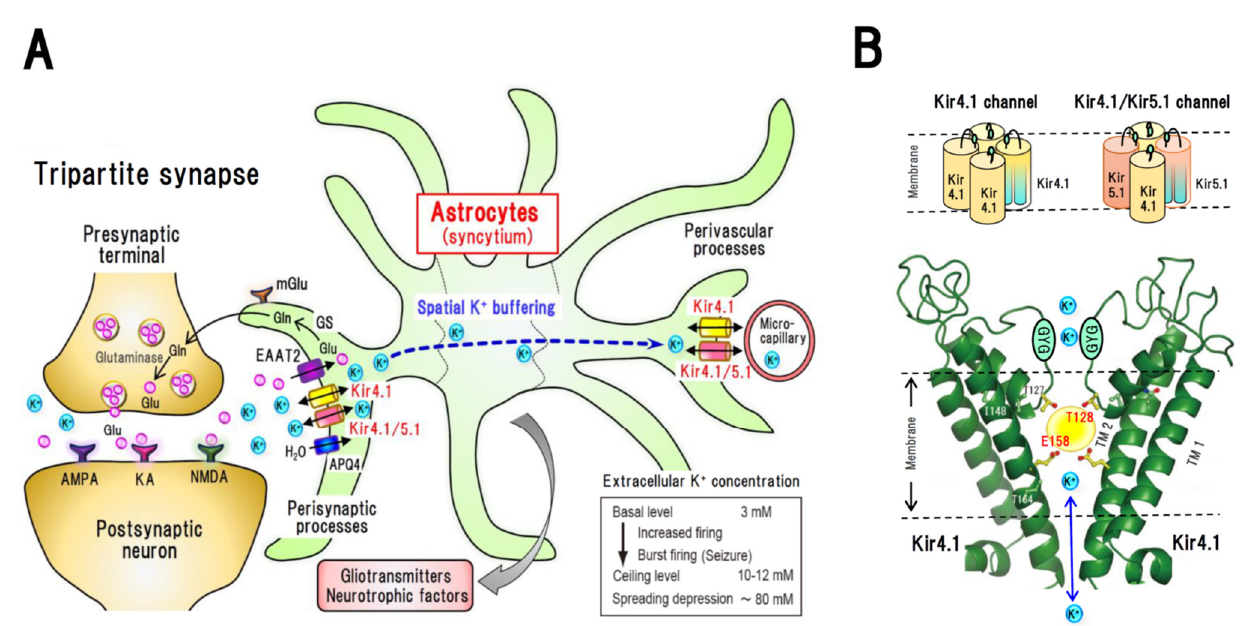
Figure 1. Spatial potassium (K + ) buffering by astrocytes in tripartite synapses and inwardly rectifying Kir4.1 channels. ( A ): Kir4.1 channel-mediated spatial K + buffering function of astrocytes. The Kir channel subunits Kir4.1 and Kir5.1 are specifically expressed in astrocytes and co-localized with excitatory amino acid transporter 2 (EAAT2) and aquaporin 4 (APQ4) in the perisynaptic processes. Astrocytic Kir4.1 channels mediate spatial K + buffering, a clearance system for excessive extracellular K + in synapses, controlling the extracellular K + levels at concentrations of 3–5 mM and maintaining the ceiling level of around 10–12 mM even during seizure discharges. When the function of Kir4.1 channels is disrupted under disease conditions, extracellular K + levels can readily increase to induce abnormal firing of neurons. AMPA: α -amino-3-hydroxy-5-methyl-4-isoxazolepropionic acid (AMPA) receptor, GS: glutamine synthetase, KA: kainic acid (KA) receptor, NMDA: N -methyl- D -aspartate (NMDA) receptor, mGlu: metabotropic glutamate receptor. ( B ): Structure of Kir4.1 channels. Kir4.1 subunits construct Kir4.1 channels by assembling homo-tetramers and Kir4.1/5.1 channels by forming hetero-tetramers with Kir5.1 subunit. Kir4.1 subunits possess two transmembrane (TM) regions, TM1 and TM2, between which an ion-selective filter containing a -G-Y-G- signature motif is located. Several compound including antidepressant drugs (e.g., fluoxetine) bind to and inhibit Kir4.1 channel-mediated currents. Two amino acid residues, T128 and E158, within the Kir4.1 subunit have been identified as specific binding sites for antidepressants and other blockers, including quinacrine, chloroquine, pentamidine, VU0134992 and aminoglycoside antibiotics. A yellow circle represents a drug-binding pocket (approximately 200 Å 3 ) estimated by the docking simulation analysis for antidepressants, where the benzene ring of antidepressants binds to T128 via a hydrogen bond and the amine moiety of these rings bind to E158 via an ionic bond.